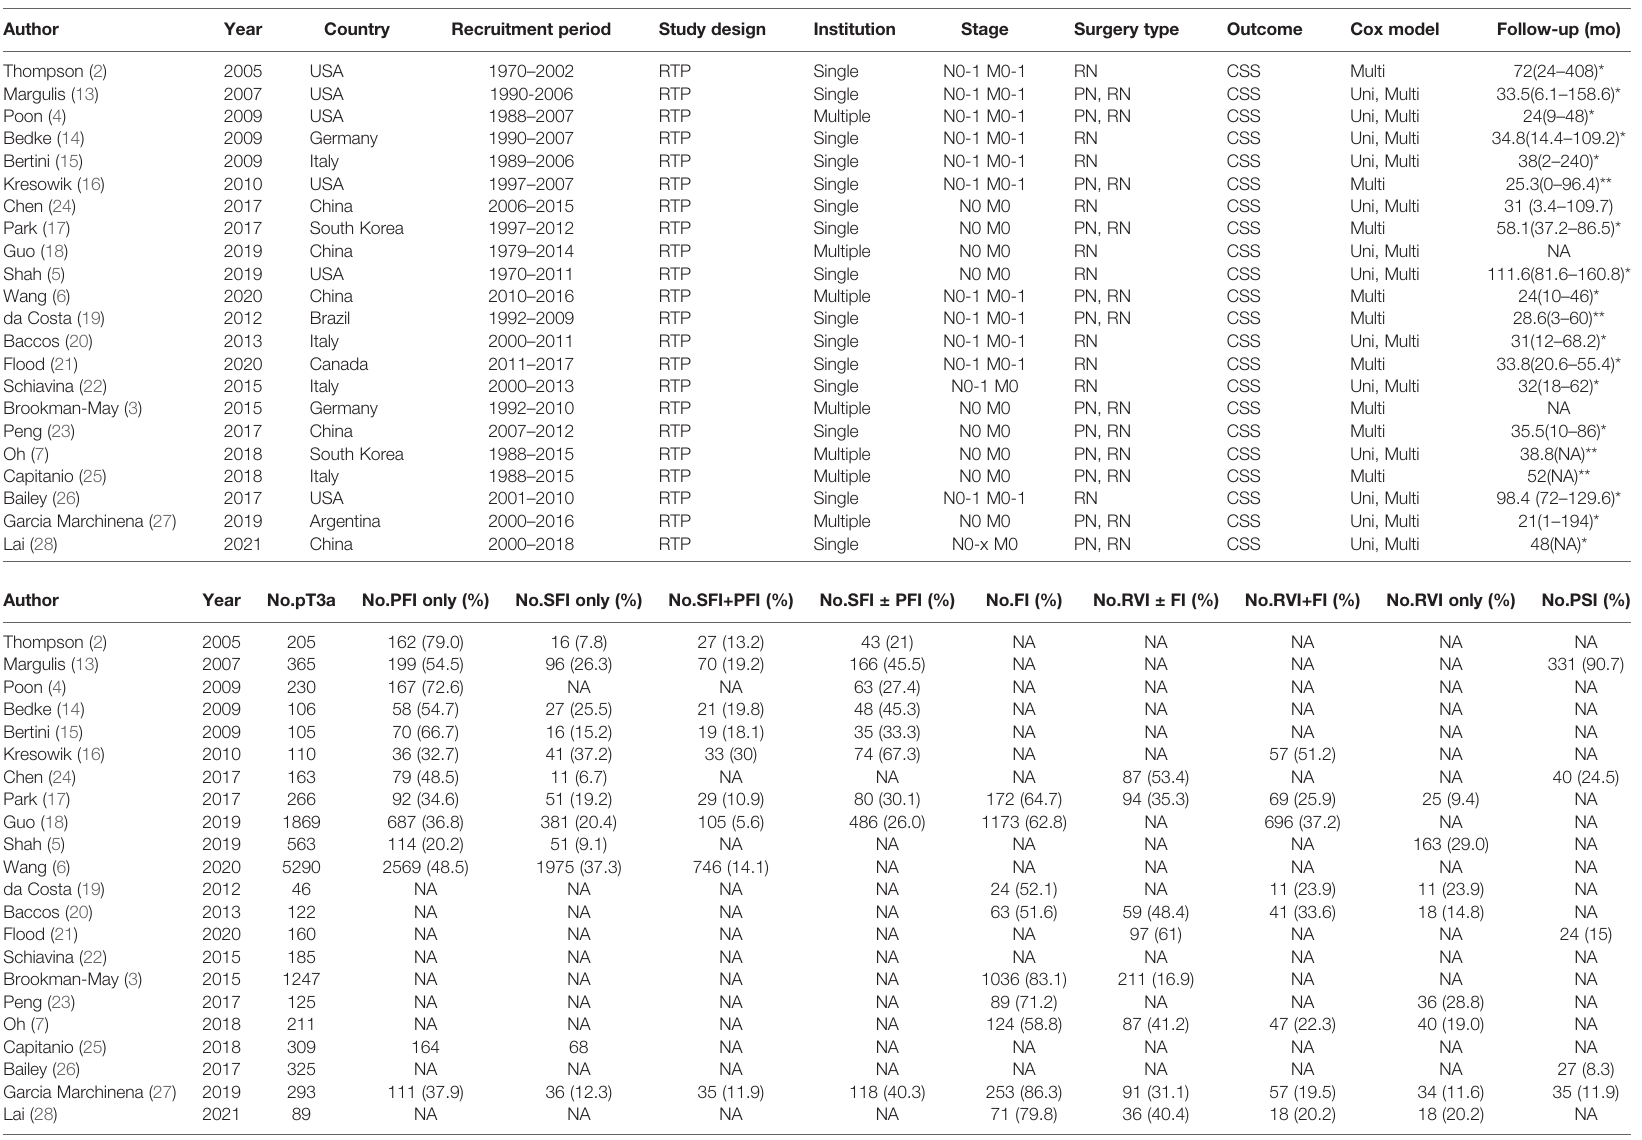
TABLE 2 | Characteristics of the included